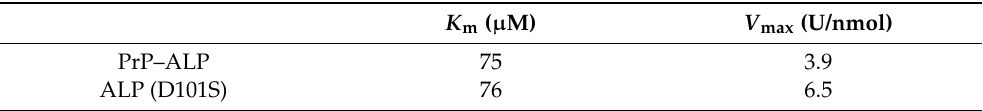
Table 1. Comparison of the kinetic parameter of enzymatic activity against p -nitrophenyl phosphate ( p NPP) between the PrP–ALP and ALP